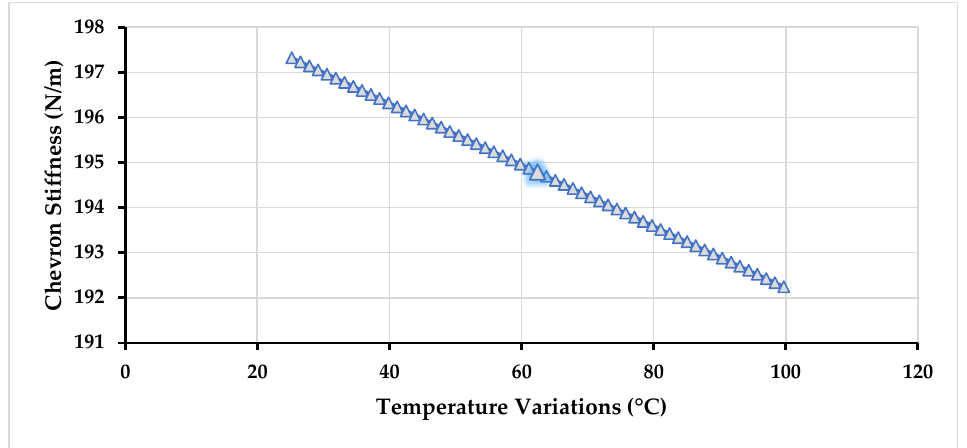
Figure 6. Force output and maximum displacement values of the electro-thermal actuator with angle variations. Micromachines 2018 , 9 , x